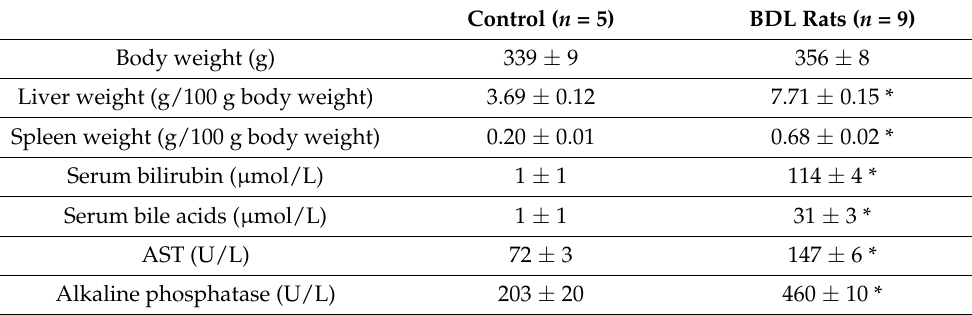
Table 1. Characterization of the animals. Rats were bile duct ligated for 4 weeks (BDL rats, n = 9) or sham-operated control rats ( n = 5). They were studied in the fed state. Data are presented as the mean ± SEM. * p < 0.05 vs.